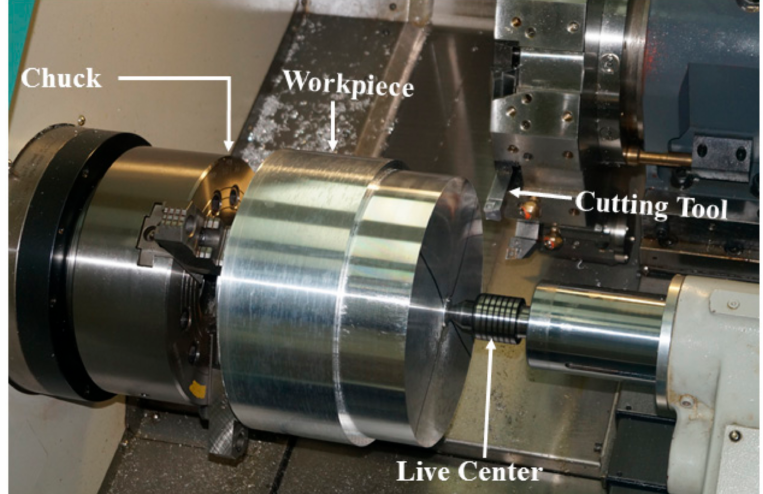
Figure 2. Turning setup used in present